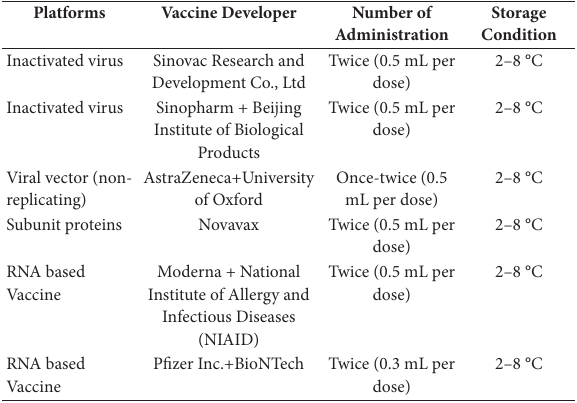
Table 1. Types of COVID-19 Vaccines in Indonesia (Forni et al. 2021; Ministry of Health of Indonesia 2021a; Park et al. 2021; WHO 2022).